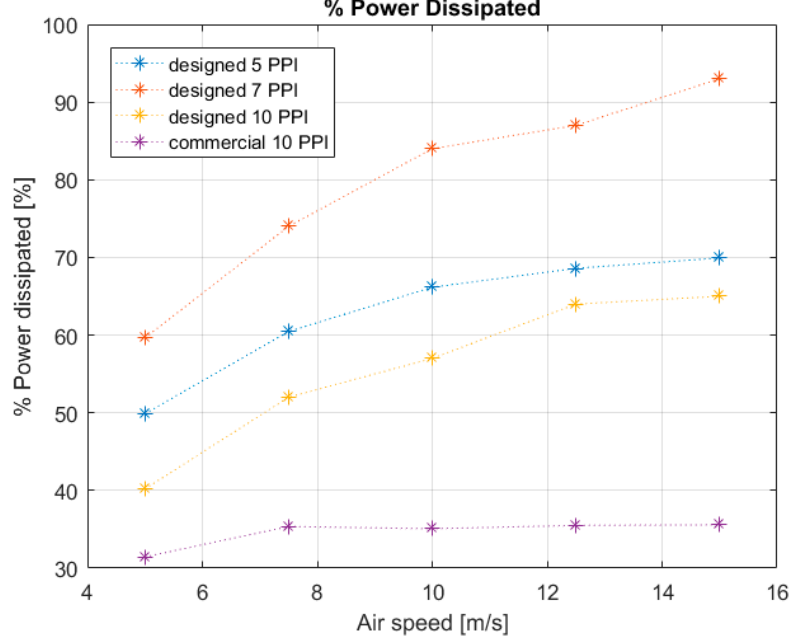
Figure 11. Percentage of power dissipated versus air speed of specific typology and comparison between the different models.